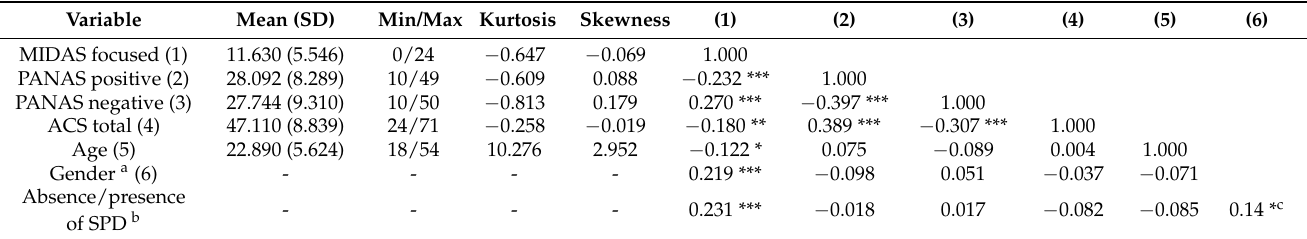
Table 1. Descriptive statistics and results of correlational